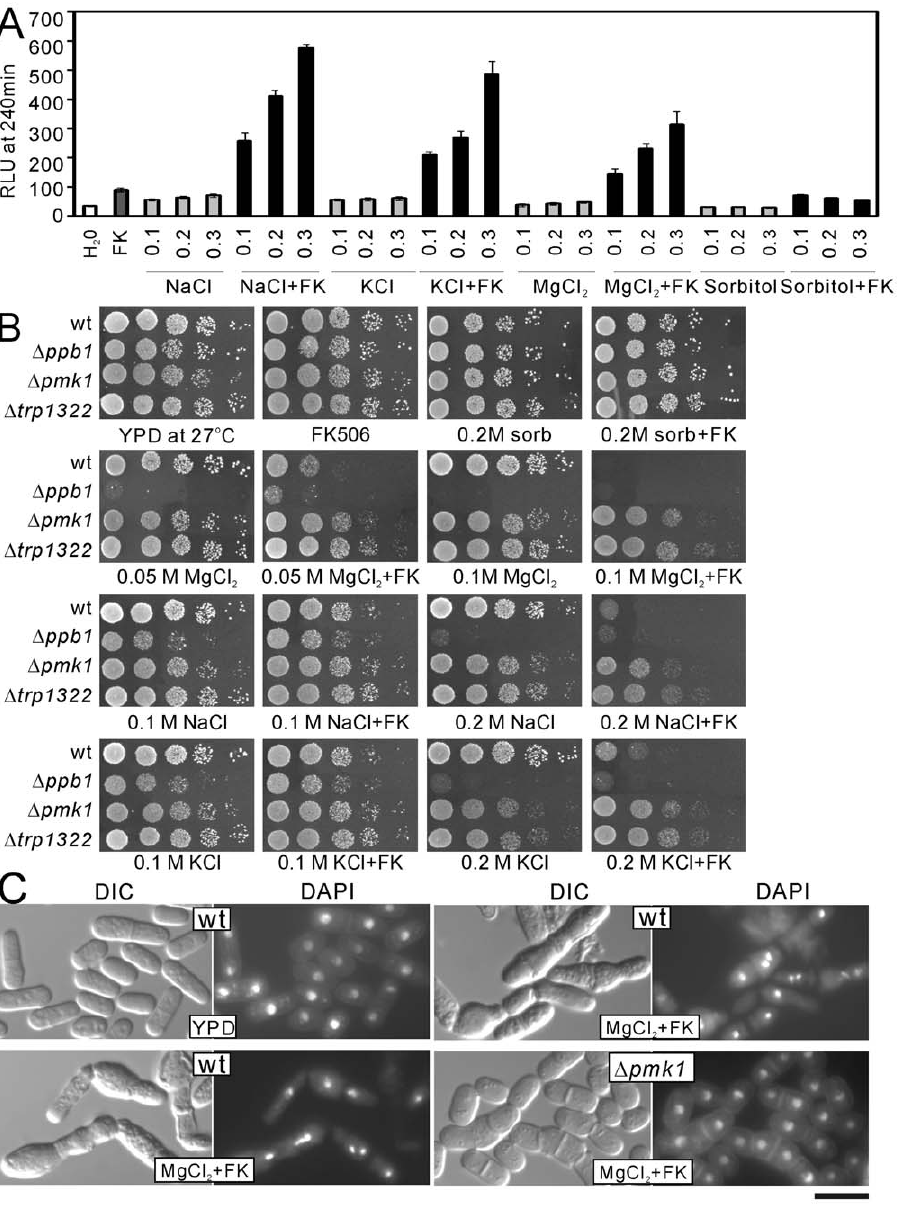
Figure 6. Salts plus FK506 caused a synergistic cytoplasmic Ca 2 + increase and caused the cell death via an apoptotic process. (A) The addition of NaCl, KCl and MgCl 2 , but not sorbitol, caused the synergistic increase in the cytoplasmic Ca 2 + level in the presence of FK506.